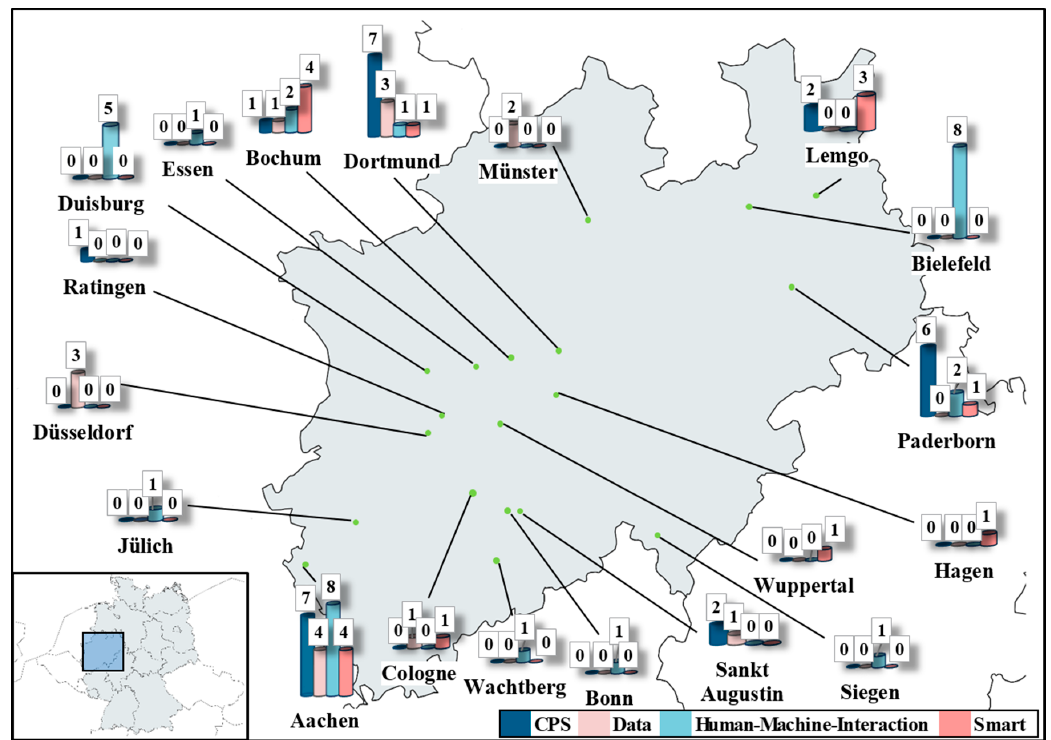
Figure 6. Papers identified in the uncorrelated regional analysis. Sources of the shapefile: [38-40].